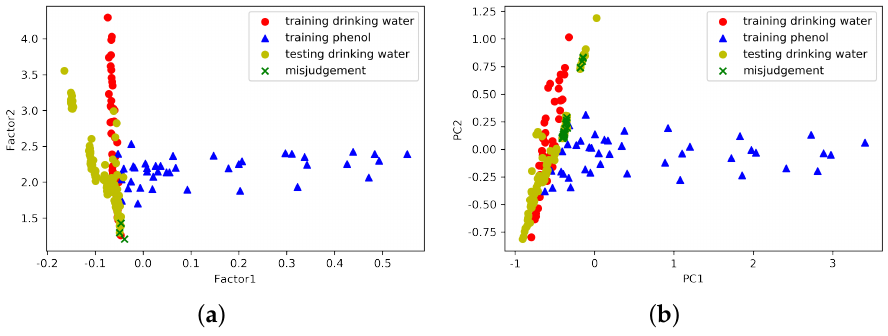
Figure 11. Drinking water features extracted by ( a ) PARAFAC and ( b ) PCA.